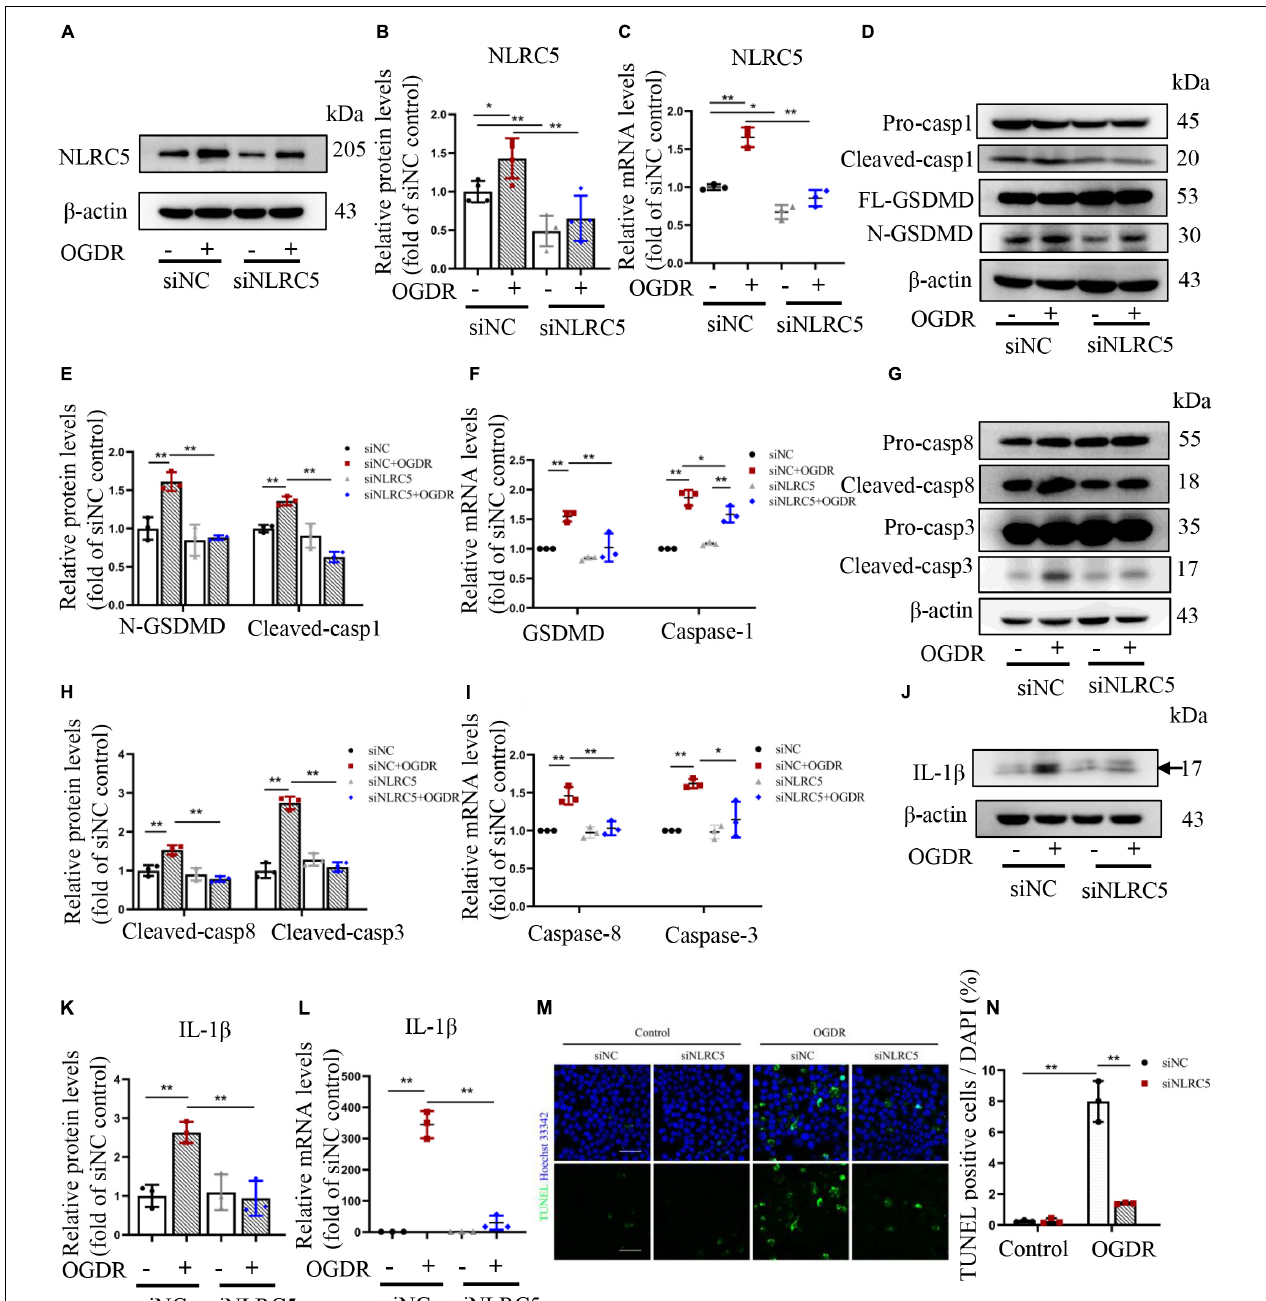
FIGURE 4 | Knockdown of NLRC5 inhibits OGDR-induced BV2 cells apoptosis, pyroptosis, and IL-1 β production. (A–C) Western blot and RT-qPCR analysis of NLRC5 expression to verify gene knockdown efficiency. (D–L) Western blot and RT-qPCR analysis showing that NLRC5 knockdown reverses the OGDR-induced upregulation of pyroptosis markers (D–F) , apoptosis markers (G–I) and mature IL-1 β (J–L) . (M,N) TUNEL staining of BV2 cells following OGDR (Scale bar: 50 µ m, Magnification: × 400). All samples were obtained after 24 h of reperfusion. All data shown are representative of at least three independent experiments and presented as mean ± SD. * P < 0.05, ** P < 0.01. Two-way ANOVA with post hoc Bonferroni tests was applied. I/R, retinal ischemia–reperfusion; OGDR, oxygen-glucose deprivation and